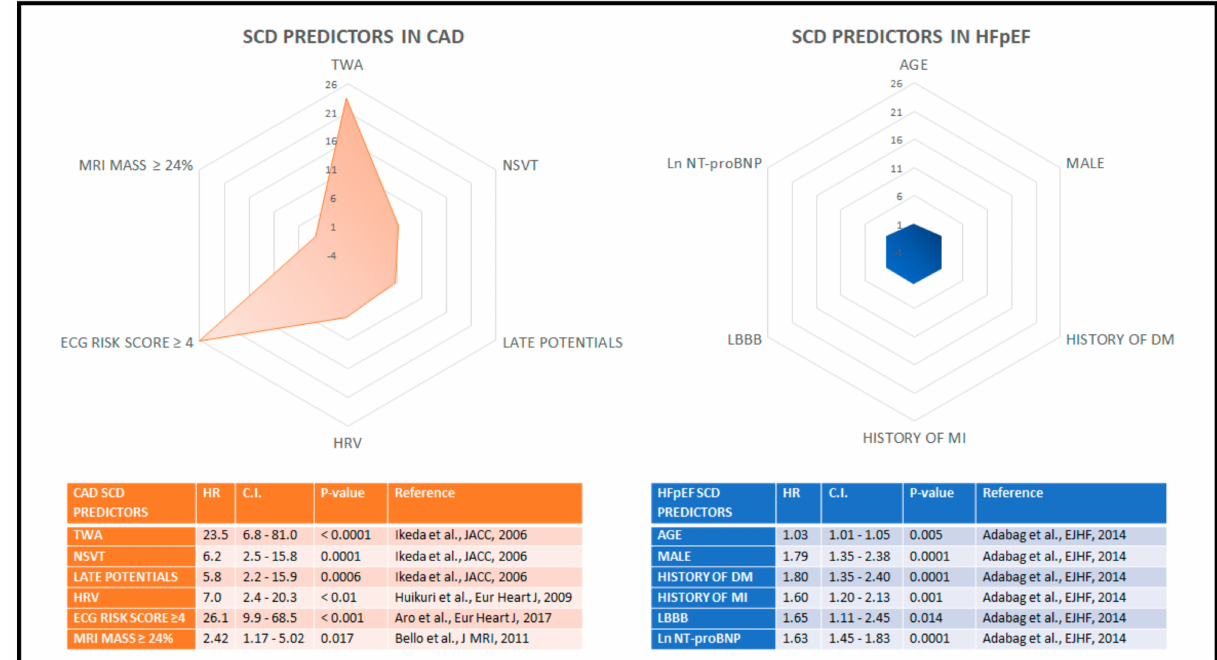
Figure 2. Predictors of sudden cardiac death. The radar graphs show the relative potency of the SCD predictors in terms of hazard ratios, in the context of CAD with preserved ejection fraction (left panel) and in HFpEF (right panel). Predictors of sudden cardiac death display a higher overall predictive power in CAD compared to HFpEF patients, as highlighted by the discrepancy between the colored areas in the polar grid, which can be interpreted as the amount of risk forecastable by available variables. CAD: coronary artery disease; HFpEF: heart failure with preserved ejection